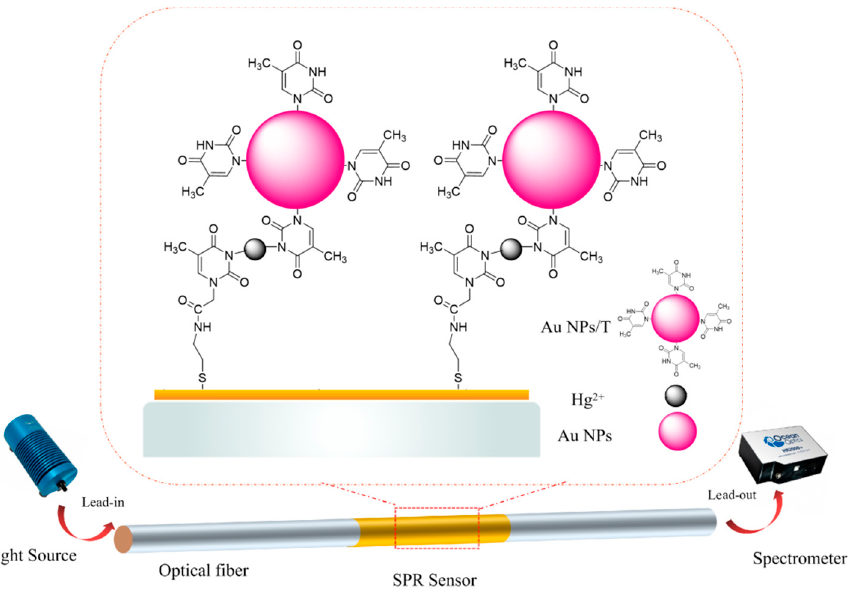
Figure 1. A schematic of the thymidine-functionalized fiber-optic surface plasmon resonance (SPR) biosensor for Hg 2+ detection.